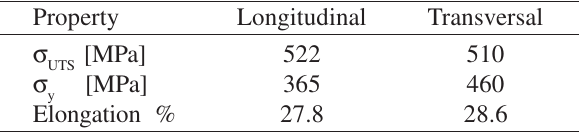
Table 1. Mechanical Properties at room temperature.